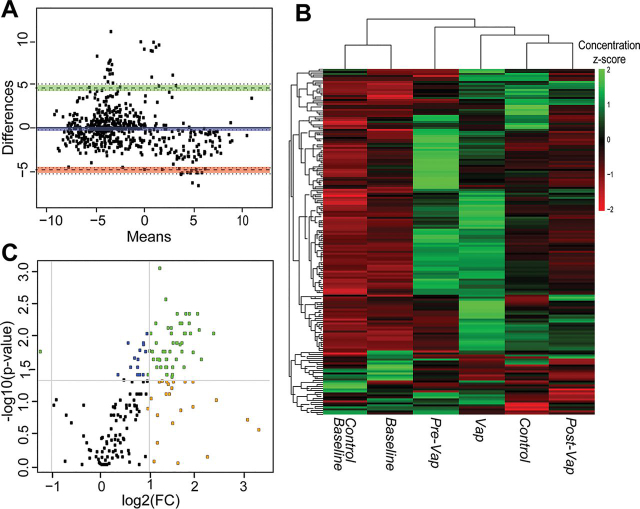
Differential metabolomic analysis.A, Bland-Altman analysis of metabolite concentrations (μm) from ETA and BAL collected on the same day. B, Temporal clustering of clinical time points using median concentrations of metabolites in ETA. C, The volcano plot indicates differential concentrations of 185 metabolites in ETA by comparing the VAP positive to Baseline. (1) In blue, significant metabolites, (2) in orange, metabolites for which the log2(FC) of metabolite concentration (VAP positive compared with Baseline) > 1 or < −1; (3) in green, significant metabolites with log2(ratio) > 1 or < −1.